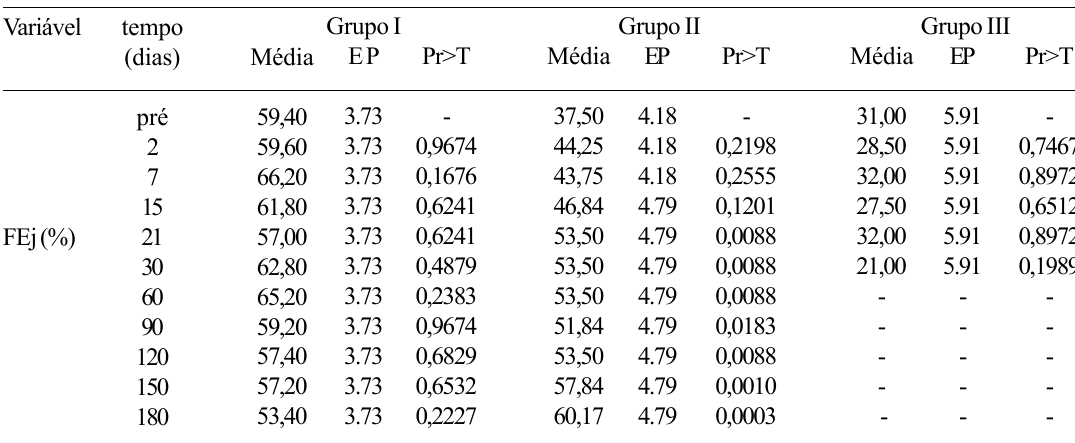
Tabela 2. Médias, erros-padrão (EP) e probabilidade em relação ao pré-operatório (Pr>T) da fração de ejeção do ventrículo esquerdo (Fej), de cães hígidos (grupo I - n=5) ou com cardiomiopatia dilatada induzida pela doxorrubicina